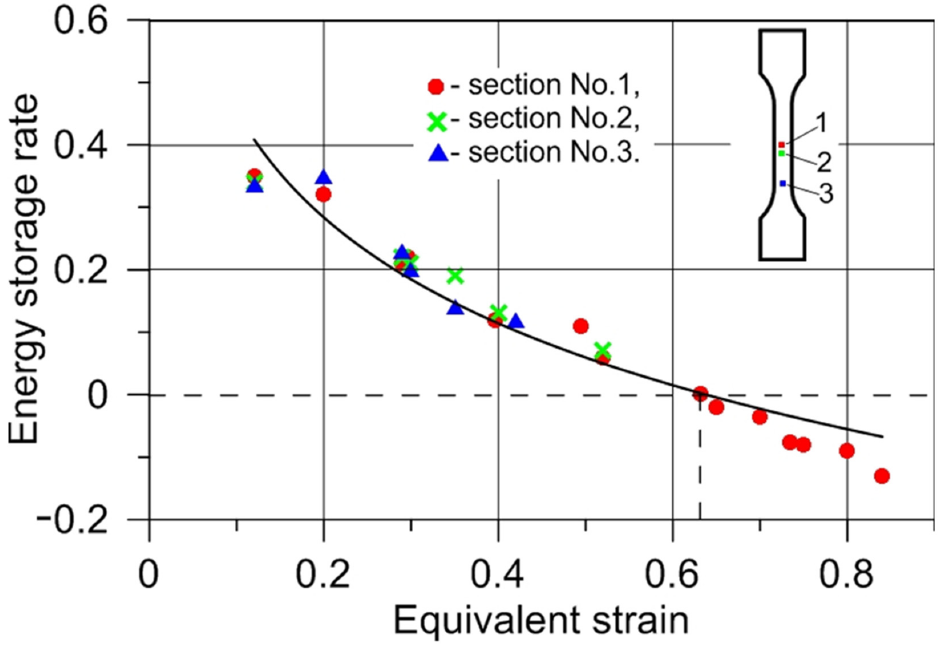
Figure 12. Energy storage rate–equivalent strain dependency during low-cycle fatigue of austenitic stainless steel.